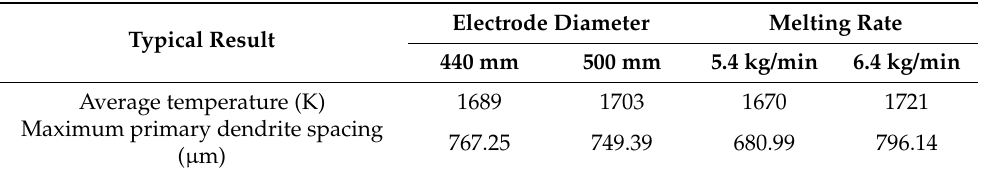
Table 3. Average temperature and solidification structure of remelted ingot under different process conditions.